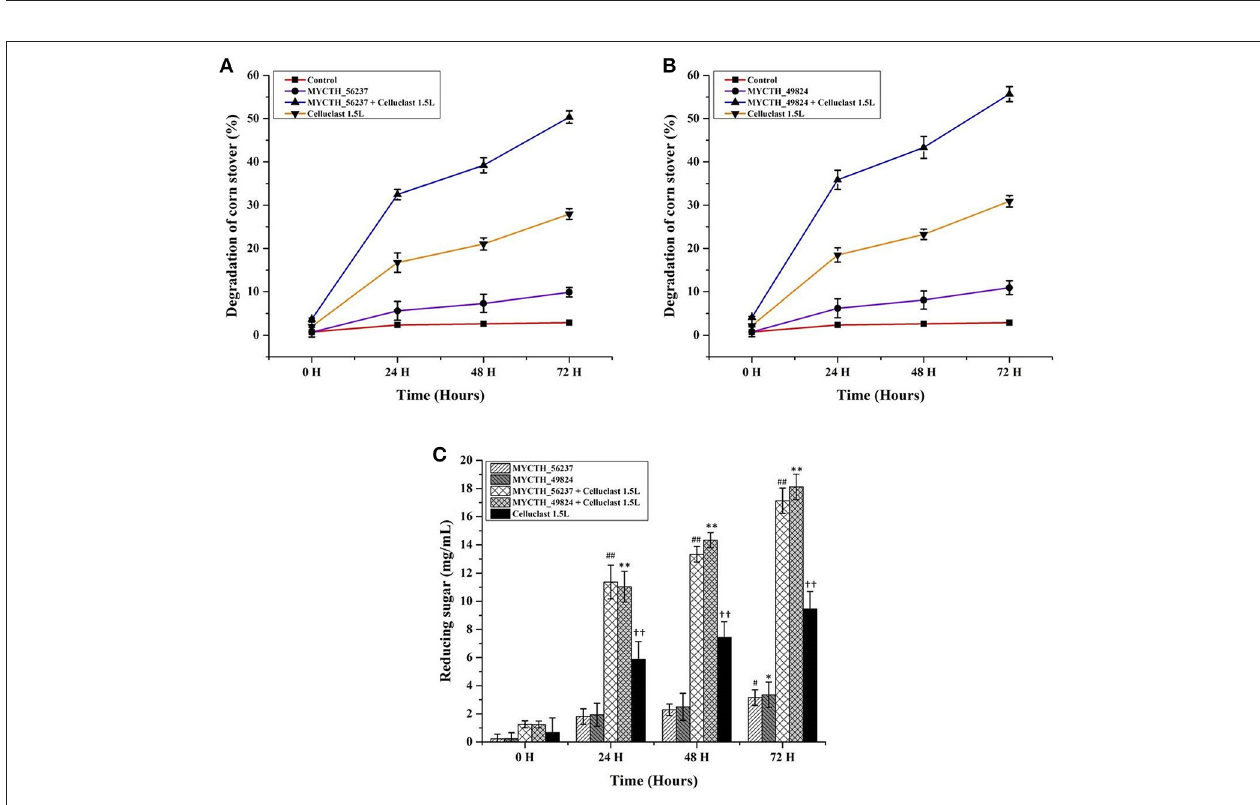
FIGURE 5 | Saccharification efficiencies of MYCTH_56237 and MYCTH_49824 in combination with commercial Celluclast 1.5L (Sigma). The pretreated corn stover was used as substrate. (A , B) Represent the degradation (%) of corn stover in the combination with MYCTH_56237 (0.6 mg/g biomass) and MYCTH_49824 (1.06 mg/g biomass), respectively, in combination with commercial Celluclast 1.5L (1.38 FPU/g biomass). (C) Represents the reducing sugar released by the enzyme(s). Data represent mean ± SD of the independent tripilcates. **, ## , †† indicates p < 0.01; while # , * indicates p <